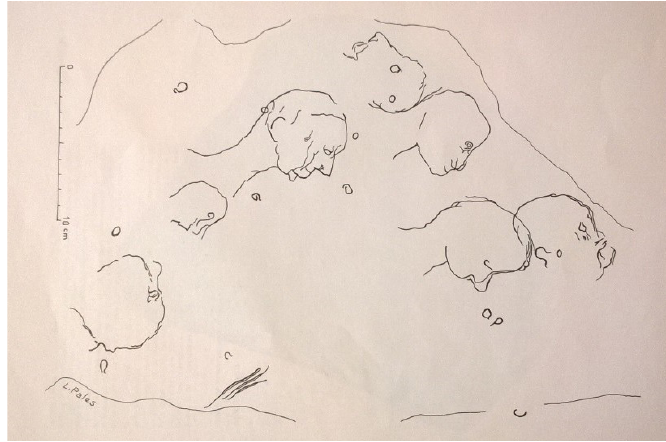
Figure 18. Group β, Obs. 63: examples of Hand β1 (II, III) and b2 (I, IV-V) (from Pales, 1976).